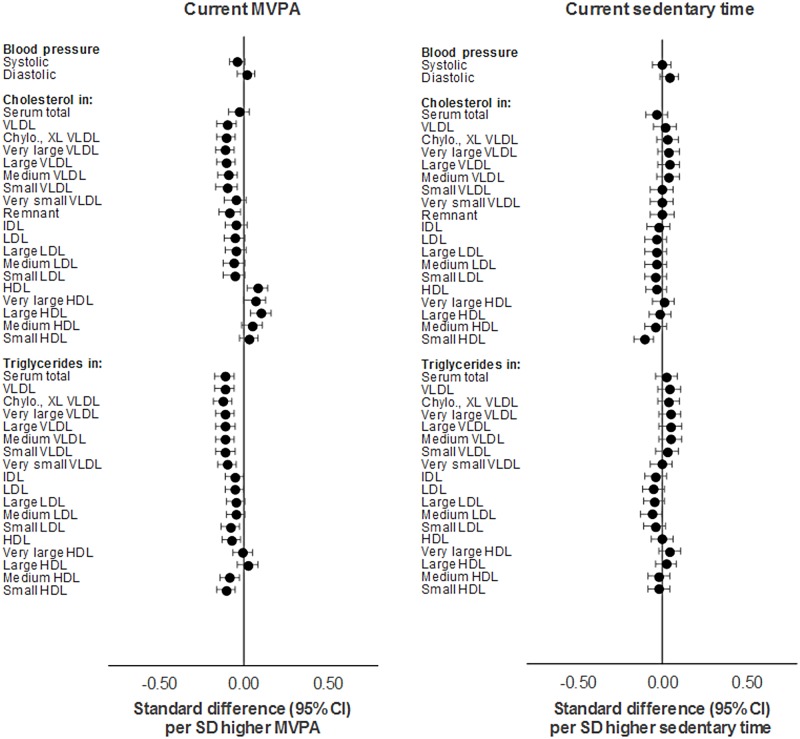
Mutually adjusted associations of current MVPA and sedentary time with blood pressure, cholesterol, and triglycerides at age 15y in ALSPAC.Metabolic traits are in standardised units. Current MVPA/sedentary time defined as measure at age 15y. Models are adjusted for age, sex, ethnicity, maternal education, device wear time and wear month, smoking, alcohol, alternative measure (MVPA or sedentary time), and fat mass index at age 15y. ALSPAC, Avon Longitudinal Study of Parents and Children; MVPA, moderate-to-vigorous physical activity.